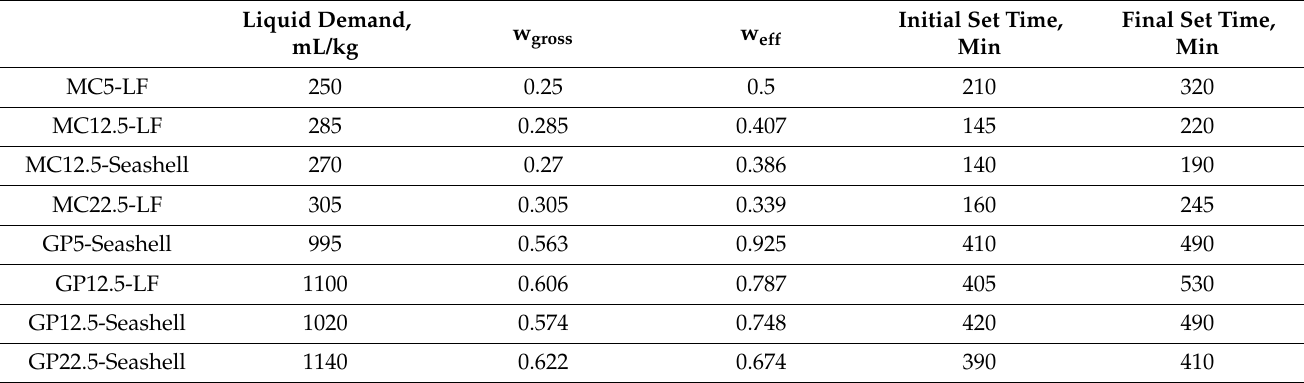
Table 2. Liquid demand for normal consistency and setting times for MC and GP